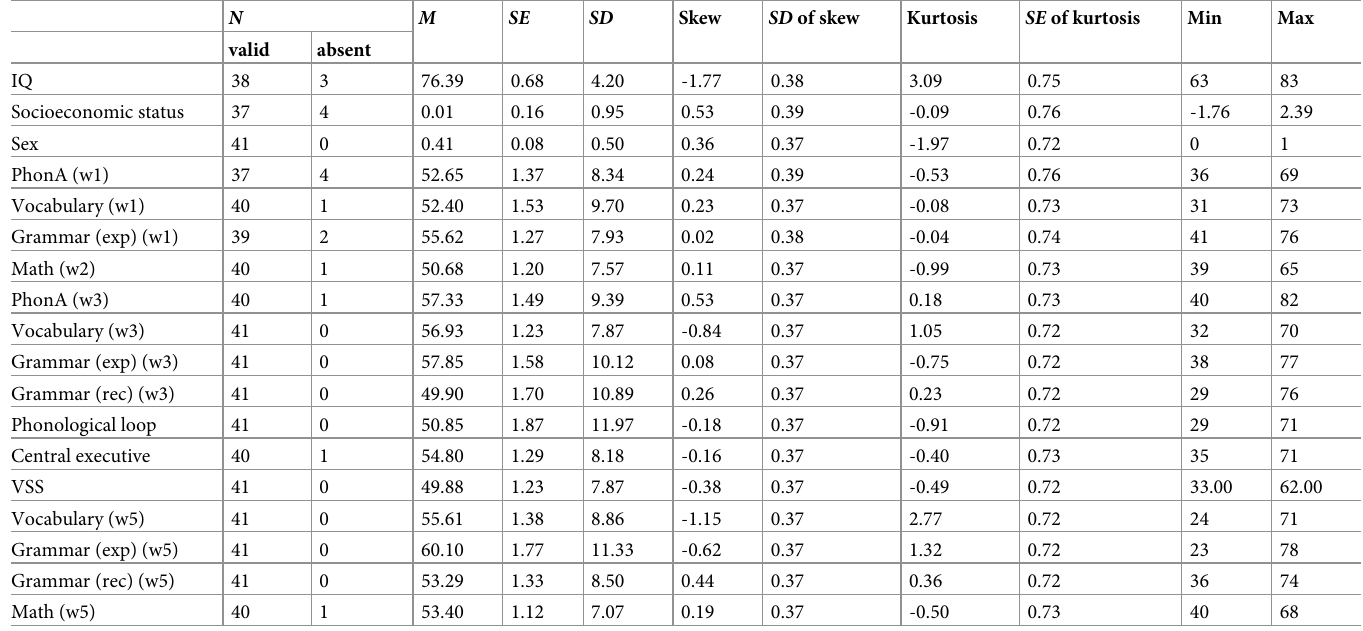
Table 1. Descriptive Analyses of all variables